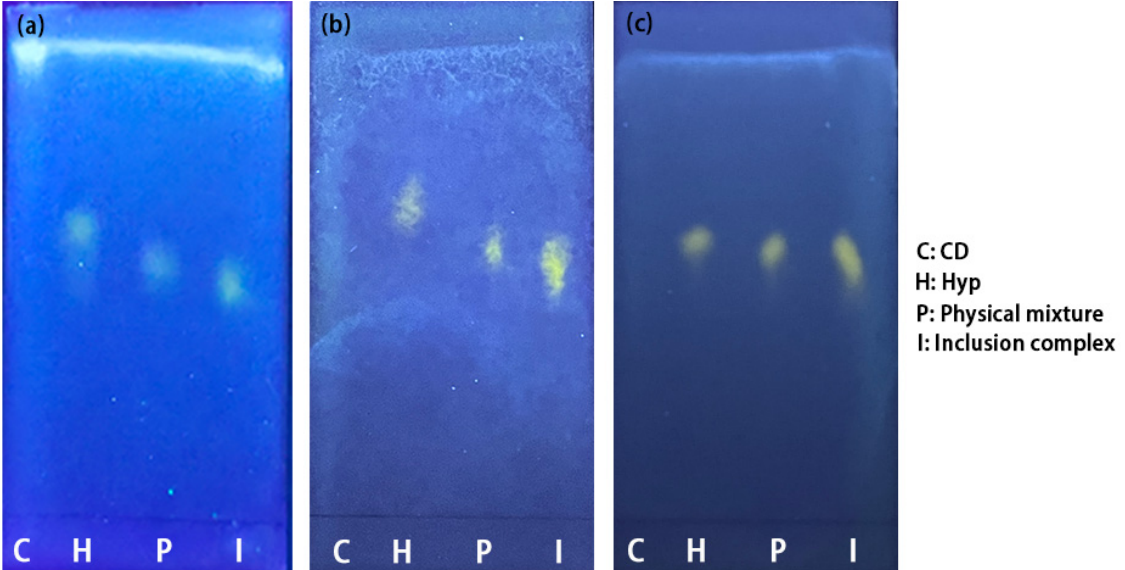
Figure 4. TGA and DSC analysis images of Hyp, CDs, ICs, and their physical mixtures. ( a , d ) Hyp/2H- β -CD complex system, ( b , e ) Hyp/ β -CD complex system, ( c , f ) Hyp/M- β -CD complex system.